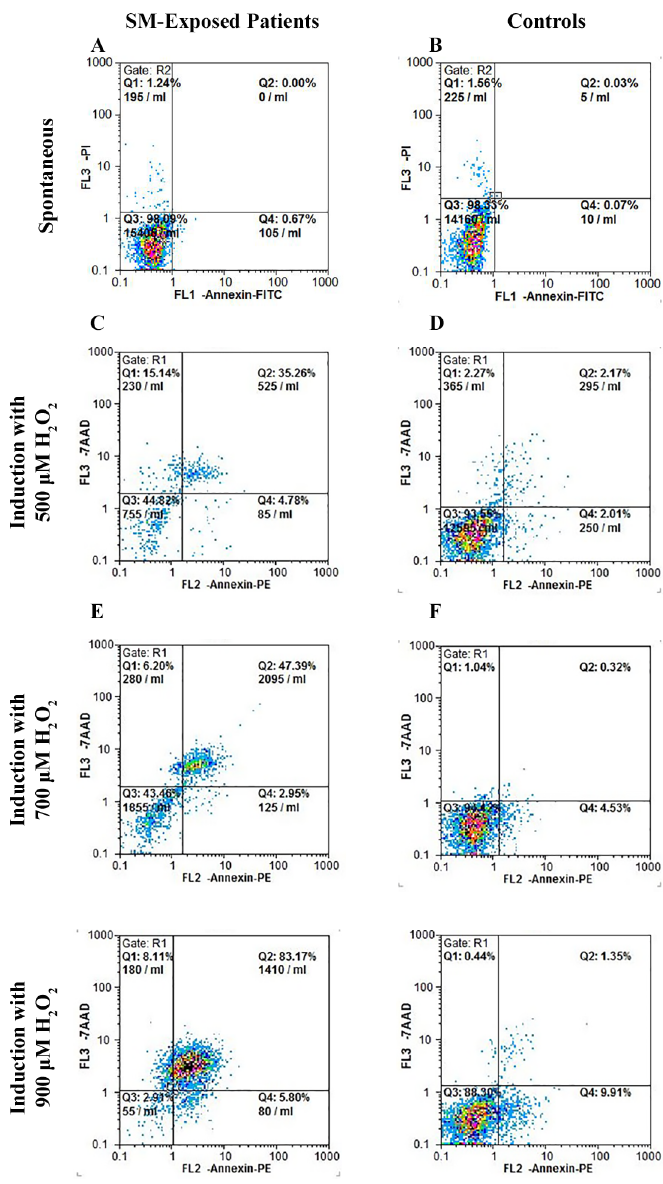
Fig 7. Flow cytometric analysis for apoptosis of fibroblasts. Representative dot plots of the flow cytometric analysis of the Annexin V – FITC/propidium iodide (PI) following induction of apoptosis with H 2 O 2 . Fibroblasts derived from SM-exposed patients and controls were assessed for spontaneous apoptosis and apoptosis following treatment with 500, 700 and 900 μ M of H 2 O 2 . Spontaneous apoptosis was not significantly different in SM-exposed patients and controls. However, a higher dose-dependent sensitivity to H 2 O 2 is observed in patients as compared with controls. Q 1 : necrotic cells, Q 2 : late apoptotic cells, Q 3 : viable cells, and Q 4 : early apoptotic